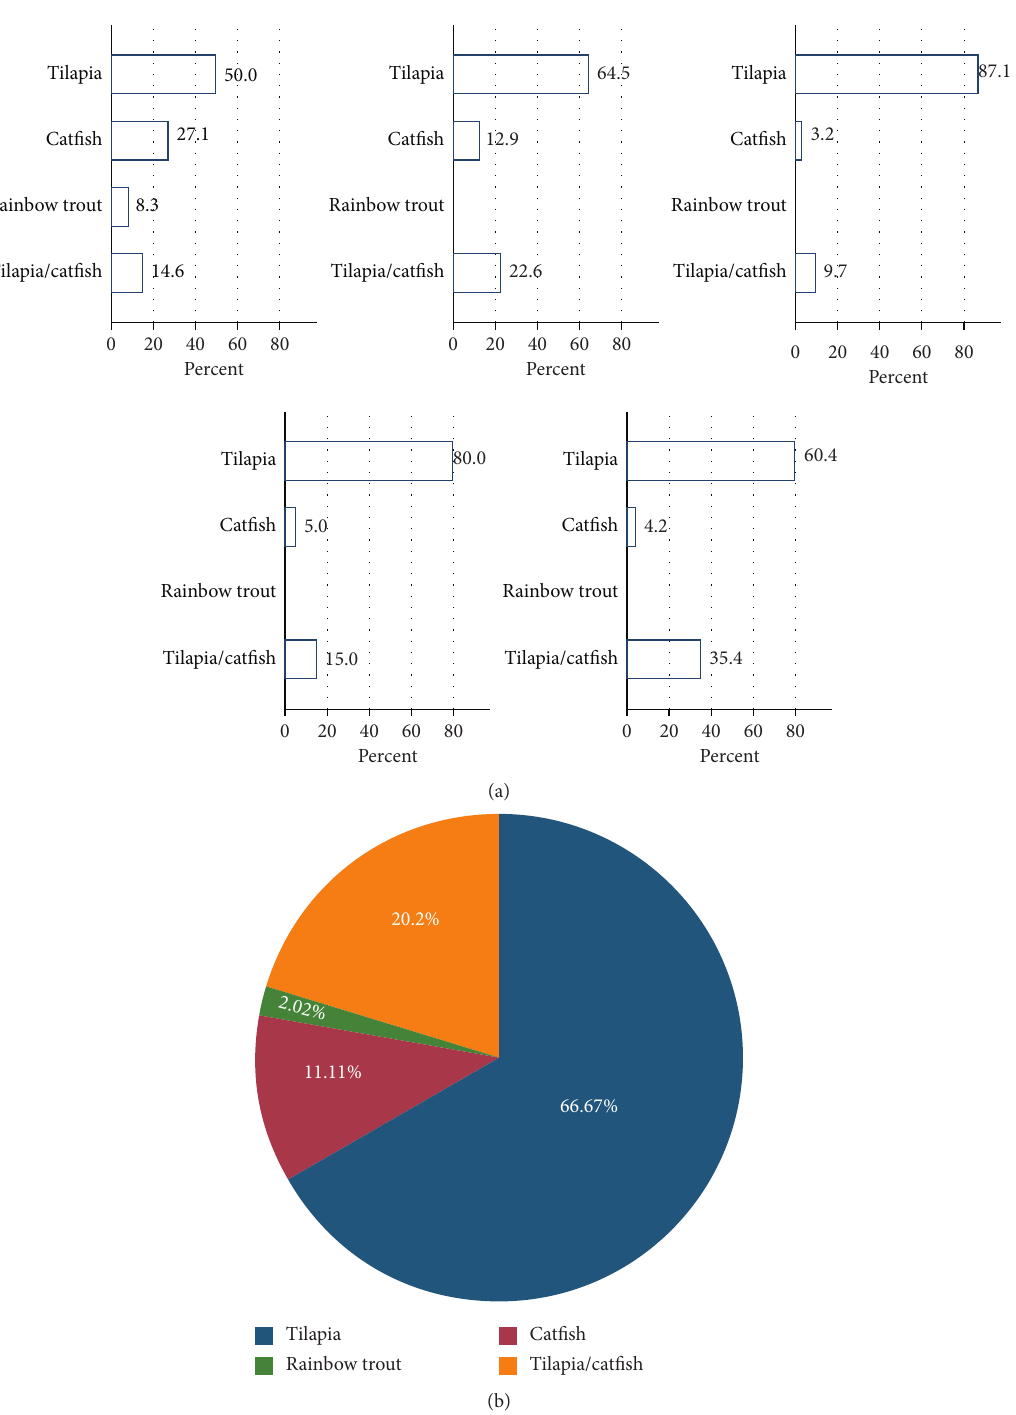
Figure 4: (a) Percentage of fish species farmed per subcounty. Tilapia was the most farmed species in all the subconties, while rainbow trout was only farmed in Kieni East subcounty. (b) Distribution for all subcounties is shown in Figure